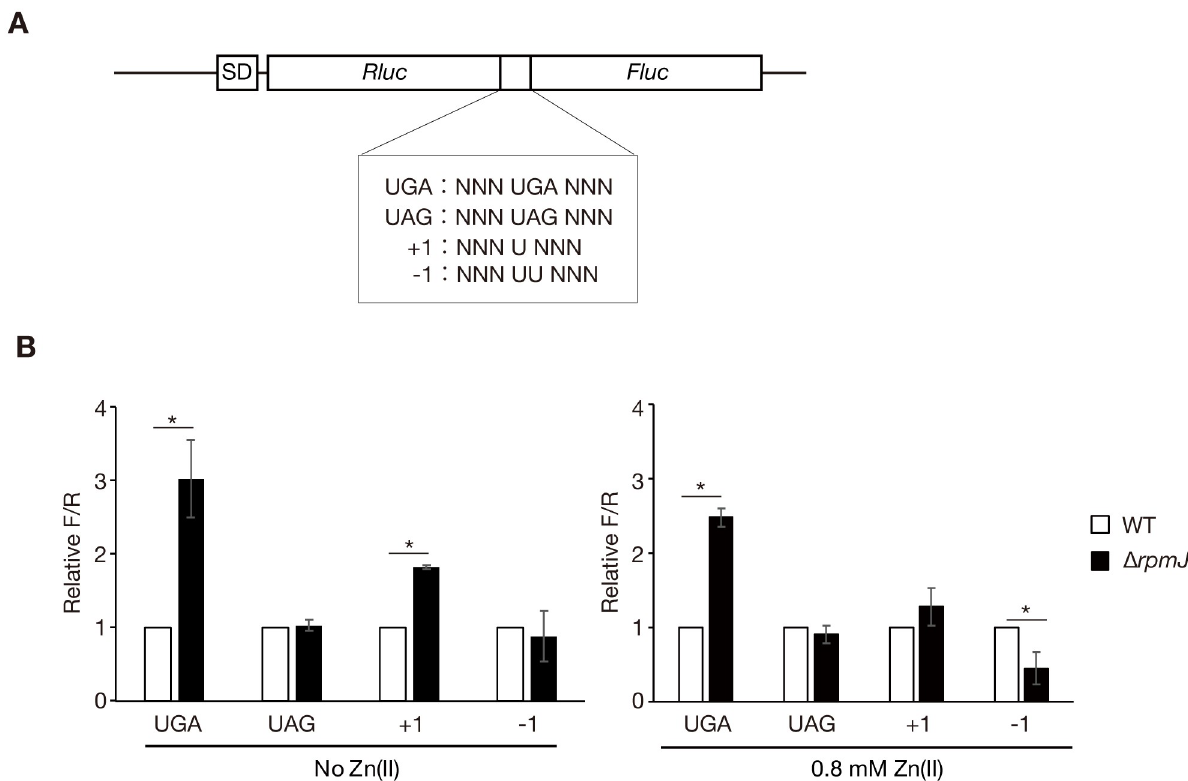
Fig 3. The rpmJ mutant had altered translational fidelity. (A) The structure of the luciferase genes used for the dual-luciferase assay is shown. Stop codons or frameshift mutations are located between the Fluc and Rluc genes. Rluc-Fluc fusion protein is expressed when reading through stop codons or when misreading frameshift mutations occur. (B) The wild-type strain (WT) and the rpmJ mutant ( Δ rpmJ ) were cultured in the presence or absence of 0.8 mM Zn(II) and luciferase activity was measured. The F/R values normalized by that of the wild-type are indicated on the vertical axis. Data shown are means ± standard deviation from 3 independent experiments. The asterisk represents a p value < 0.05.